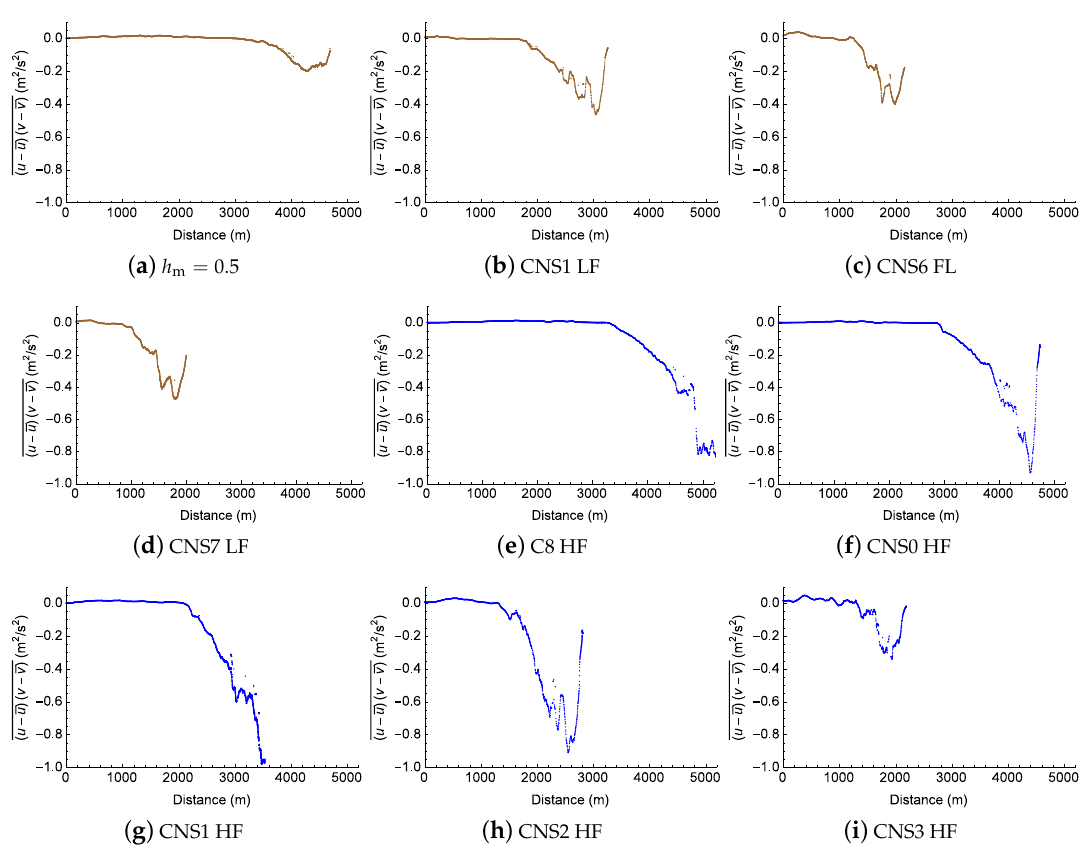
Figure 7. Profiles of the momentum flux by the differential advection ( u − u )( v − v ) across the sampling transects. The brown and blue plots correspond to relatively low and high flow conditions,